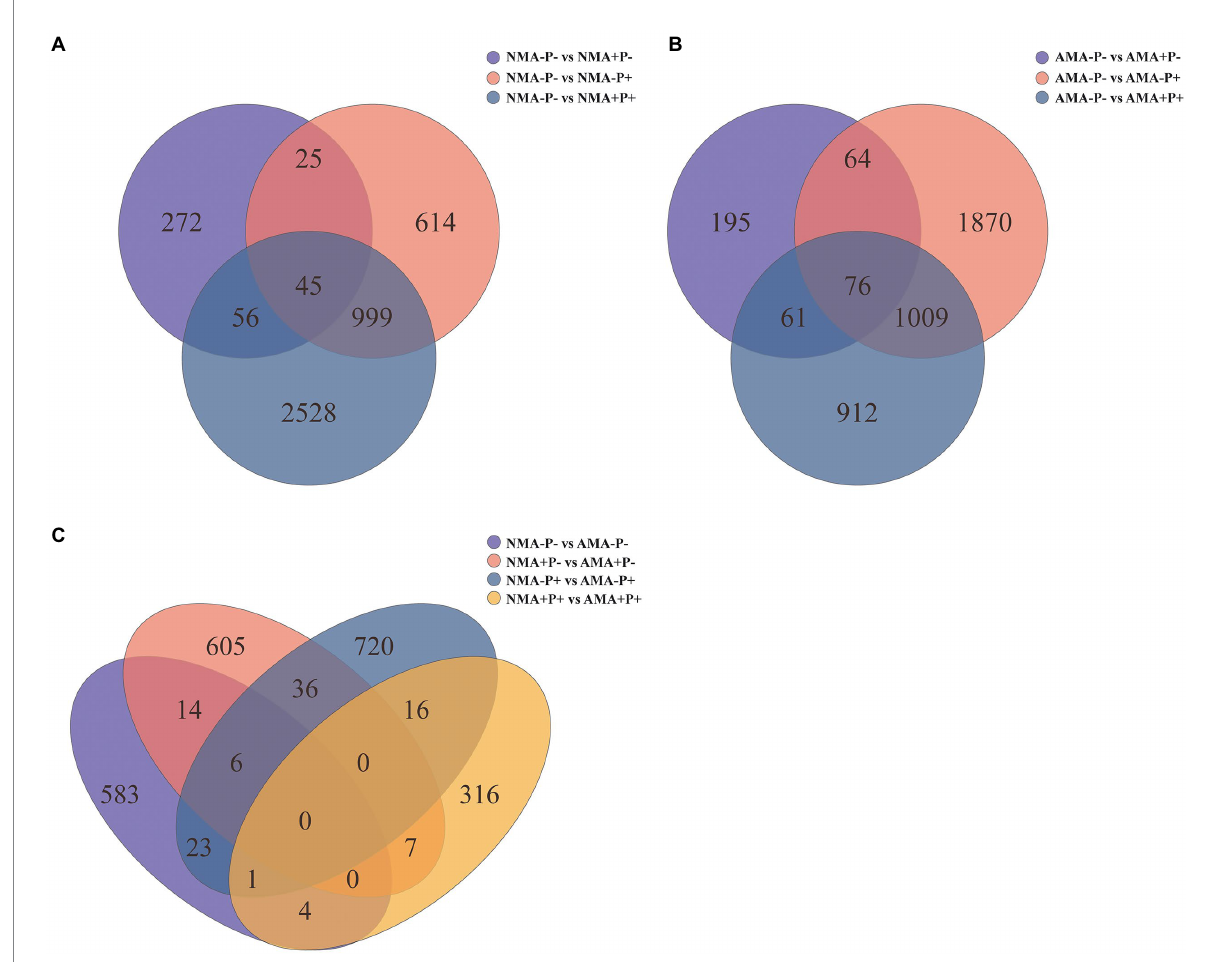
FIGURE 6 Venn diagram of (A) the three gene sets NMA − P − vs. NMA+P − , NMA − P − vs. NMA − P+, and NMA − P − vs. NMA+P+, (B) the three gene sets AMA − P − vs. AMA+P − , AMA − P − vs. AMA − P+, and AMA − P − vs. AMA+P+, and (C) the four gene sets NMA − P − vs. AMA − P − , NMA+P − vs. AMA+P − , NMA − P+ vs. AMA − P+, and NMA+P+ vs.